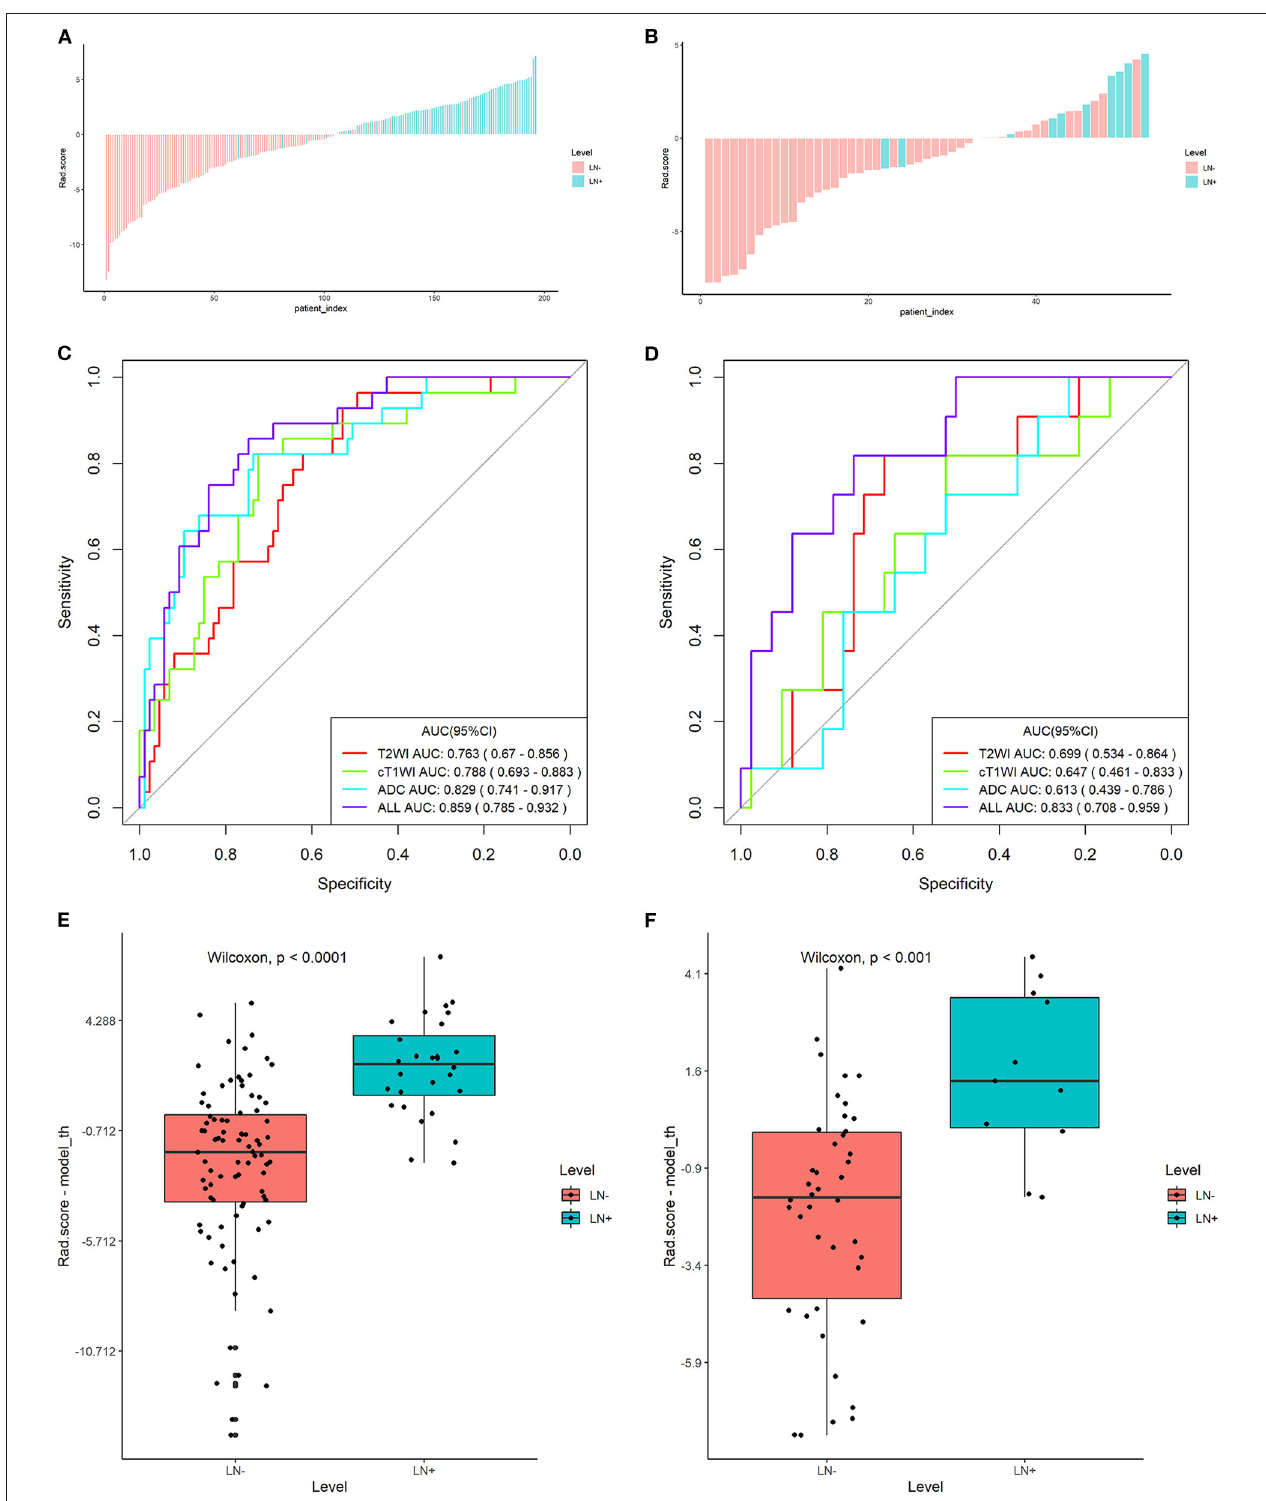
FIGURE 3 | Plots (A,B) show the Rad-score for each patient, plots (C,D) show the receiver operating characteristic (ROC) curves of the radiomics signature derived from T2W, ADC, and cT1W images and their combination, and plots (E,F) present the boxplots of the Rad-score in the training and validation sets, respectively.